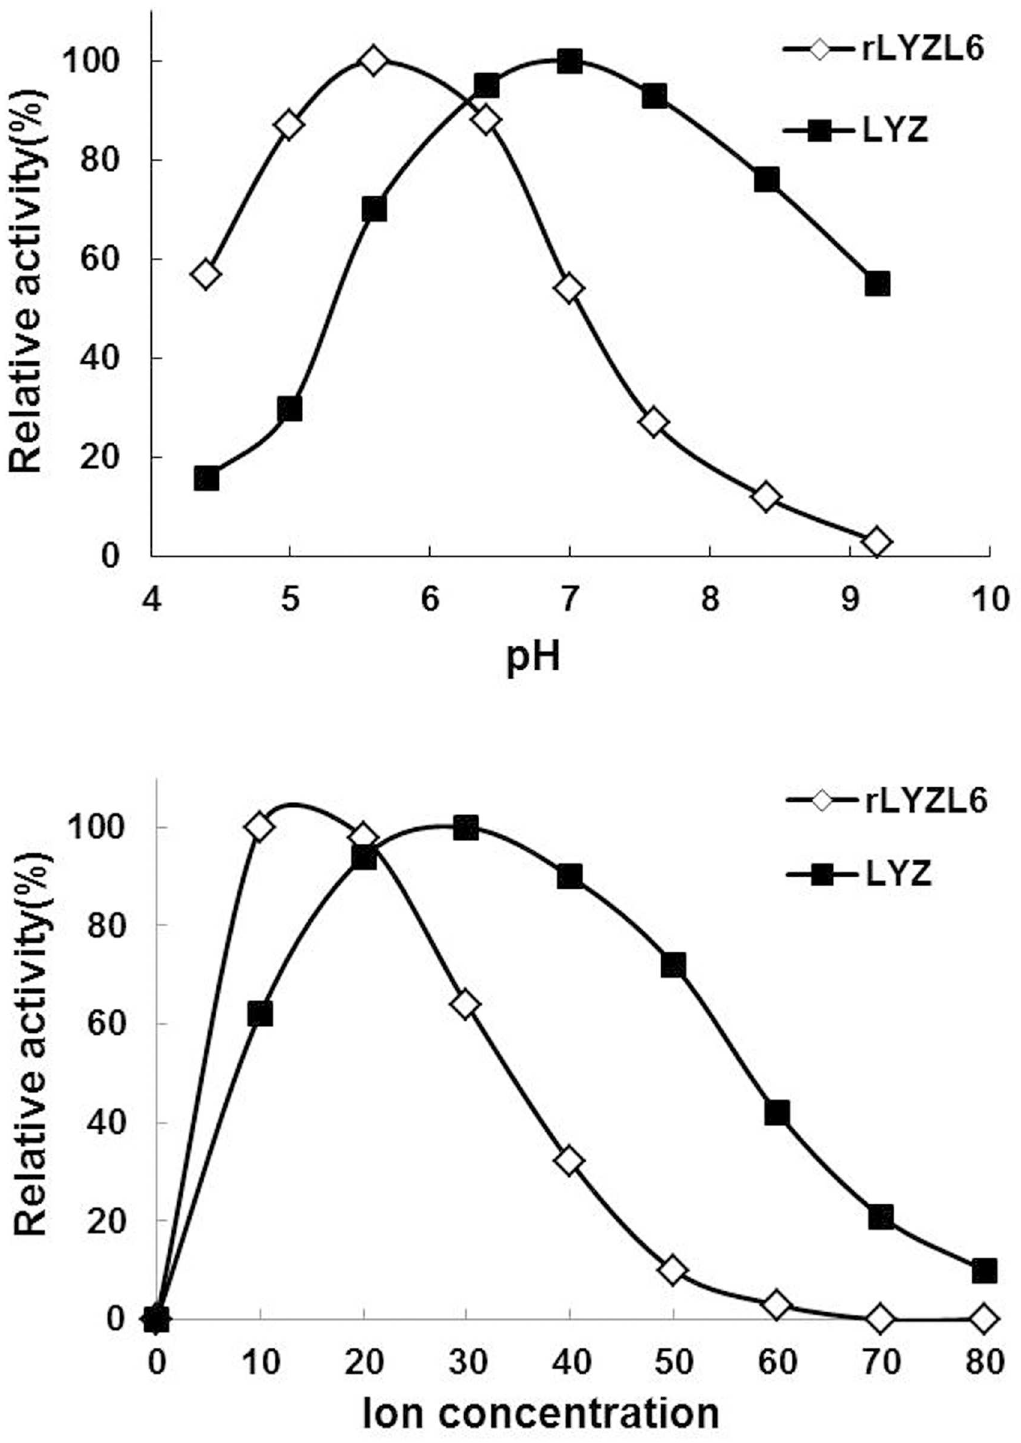
Fig 5. Effect of pH and ion concentration on the activity of rLYZL6. A) Activities of rLYZL6 and LYZ at different pH values, with a maximum activity at pH ~5.6. B) Effect of Na + ion concentration on activities of rLYZL6 and LYZ. For all of the assays, rLYZL6 solutionwas added to substrate suspensionand identicalamounts of humanmilk LYZ were used as controls. All values have beennormalizedto the peak activity for each curve (100%).